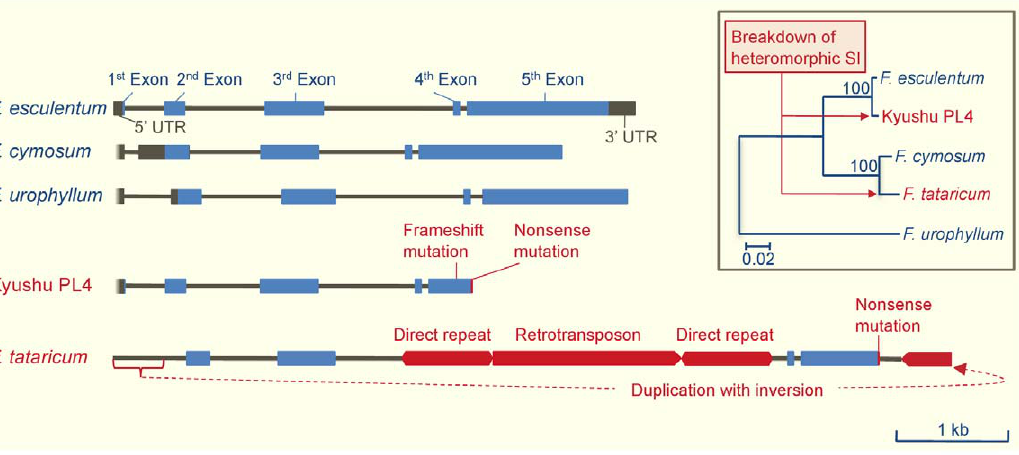
Figure 7. S-ELF3 in Fagopyrum species. The gene structure and phylogeny of S-ELF3 in five Fagopyrum species, including the SC Kyushu PL4 line, which contains the S h allele of F. homotropicum , are shown. Species in blue and red font exhibit heteromorphic SI and homomorphic SC, respectively. Dark brown boxes and lines represent 5 9 - and 3 9 -untranslated regions and introns, respectively. Coding regions are colored blue. Red boxes and line indicate large insertions ( . 400 bp) and nonsense mutation, respectively. The phylogenetic tree in the inset was obtained by the Neighbor-joining method. The S-ELF3 sequence from F. urophyllum was used as an outgroup. The bootstrap numbers (500 replicates) are shown next to the branches. The scale bar corresponds to 0.02 substitution per nucleotide site.